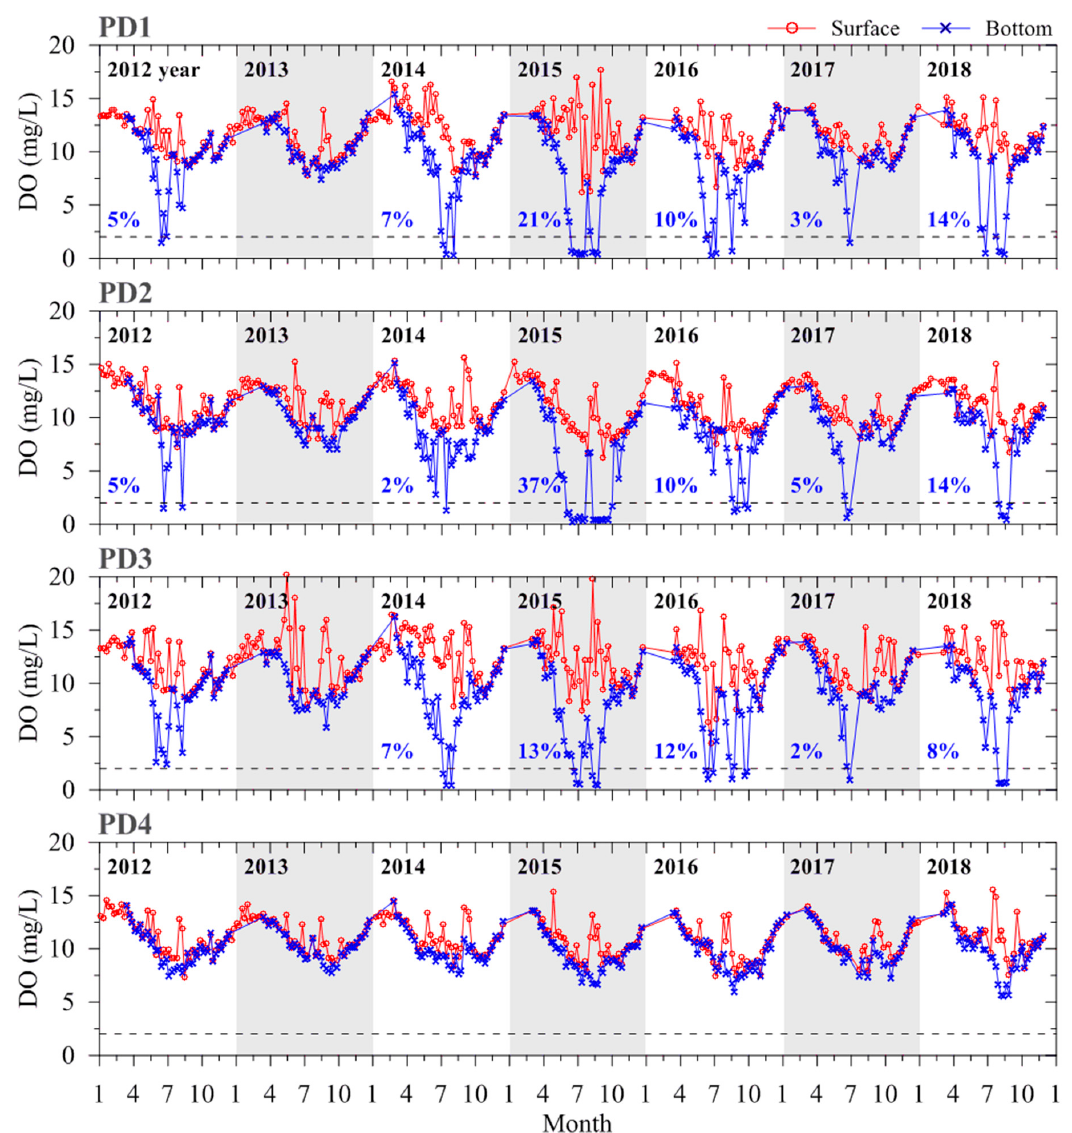
Figure 12. Time series of dissolved oxygen (DO) by water depth for each monitoring station.